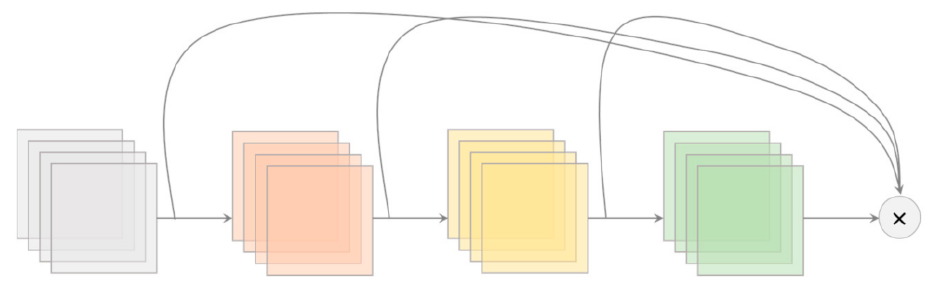
Figure 5. One Shot Aggregation (OSA).